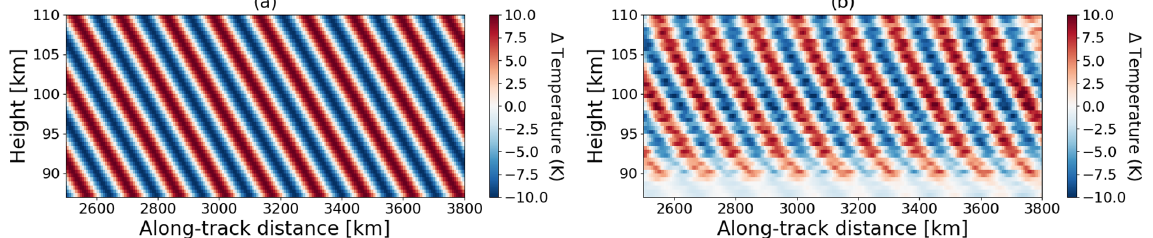
Figure 10. Simulated GW (a) with a vertical wavelength of 10km and horizontal wavelength of 150km, and retrieved wave structure (b) assuming a turning angle α of 0 ◦ .